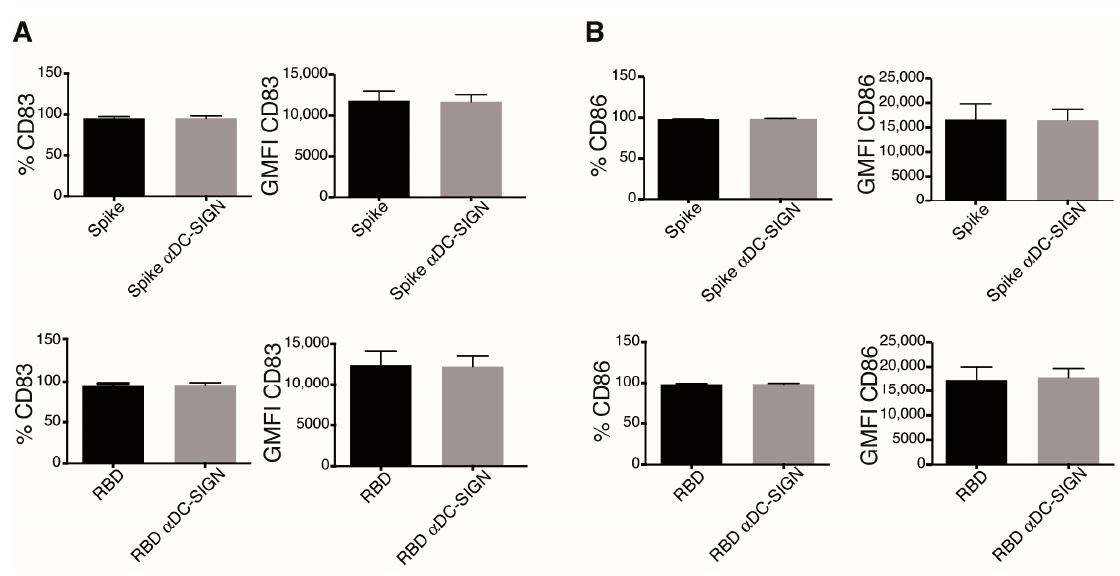
Figure 7. Dendritic cell activation in response to Spike protein and the RBD is DC-SIGN independent. iDCs were preincubated with an anti-DC-SIGN antibody, stimulated as indicated for 24 h, and then stained and analyzed by flow cytometry. ( A ) CD83 and ( B ) CD86 expression in DCs with the indicated treatment are shown. Graphs show percentage of positivity (left) and GMFI (right) of each marker. Graphs show mean ± SEM; n = 5 different